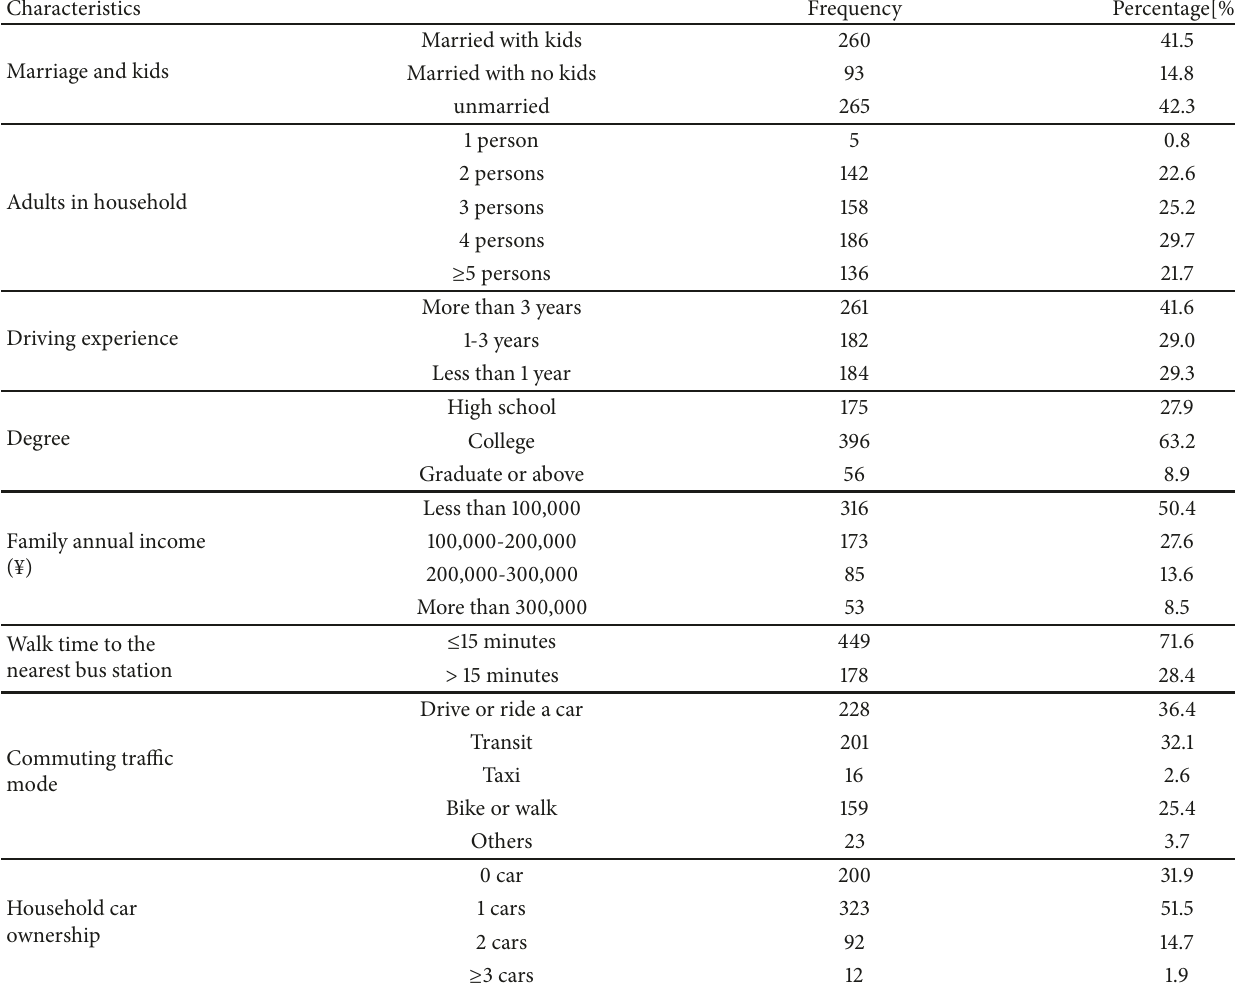
Table 4: Sociodemographics of members that were surveyed.